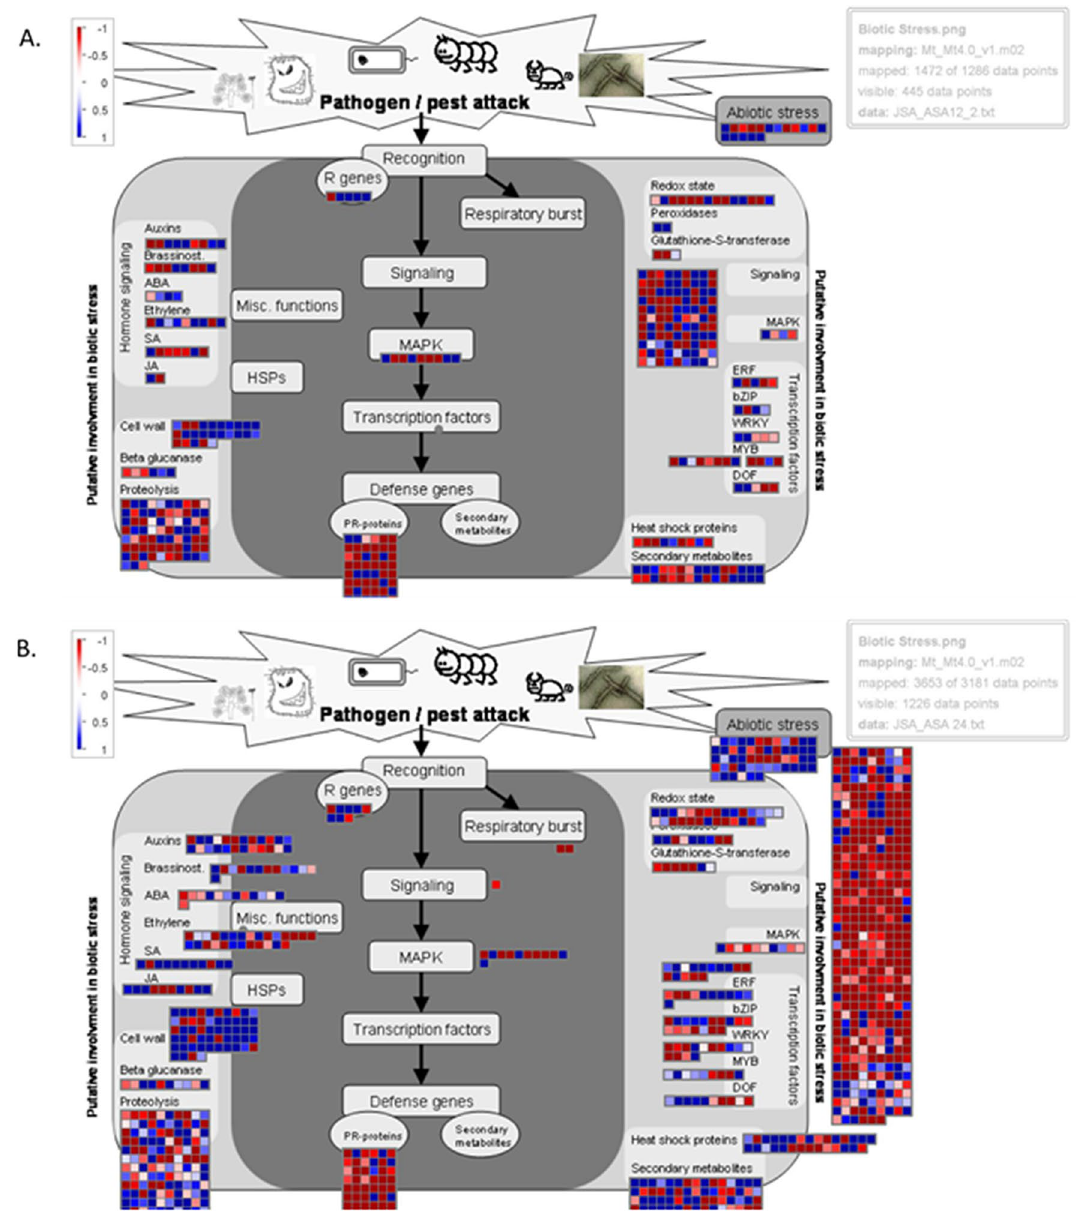
Mapman analysis 25 . Activated genes are shown as blue squares whilst repressed genes in Jester compared to A17 are shown in red as indicated by the colour scale on the top left (LOG 2 fold change). The defense response intensifies over time with the number of signaling genes increasing, albeit with the majority of them down- regulated in Jester ( B